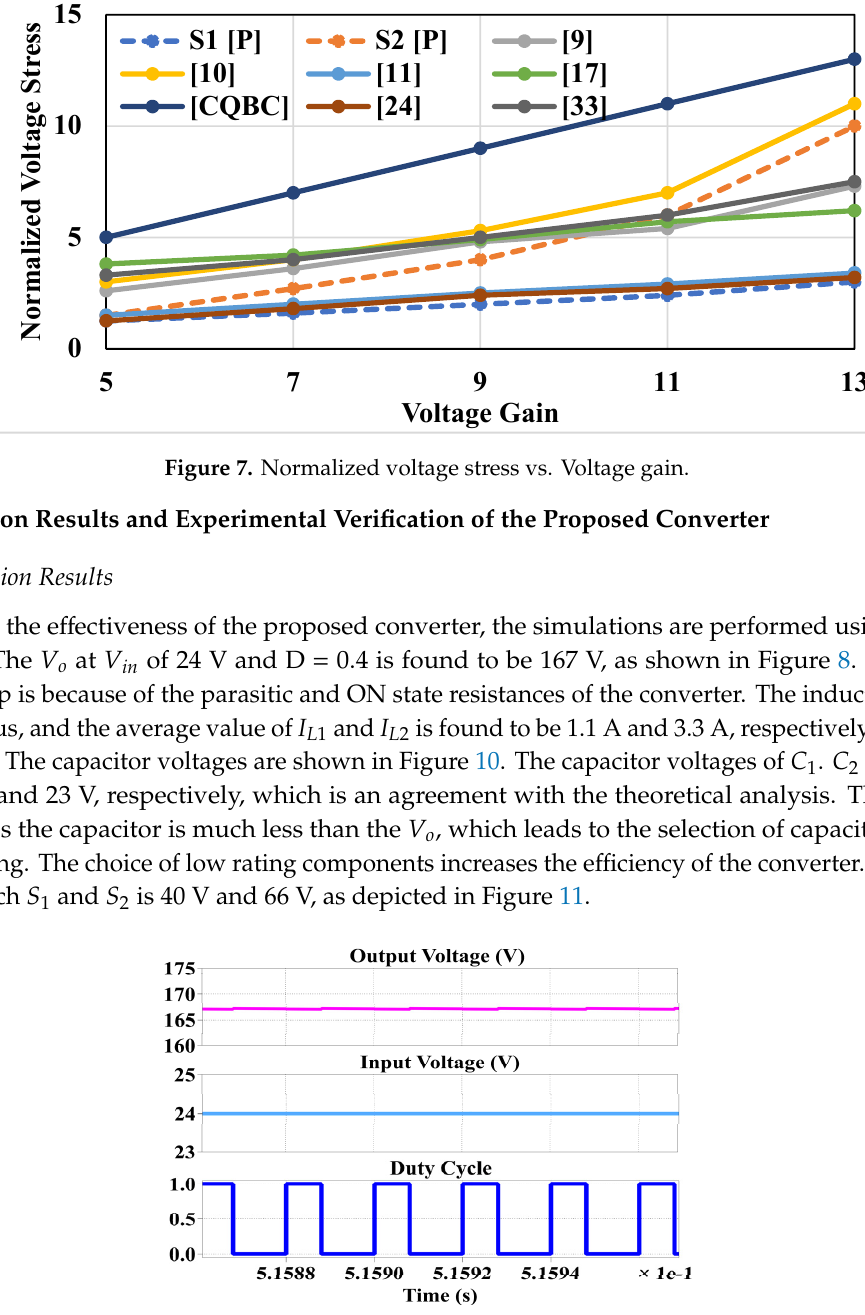
Figure 6. Comparison of Voltage gain vs. Duty ratio of proposed converter with other converters .